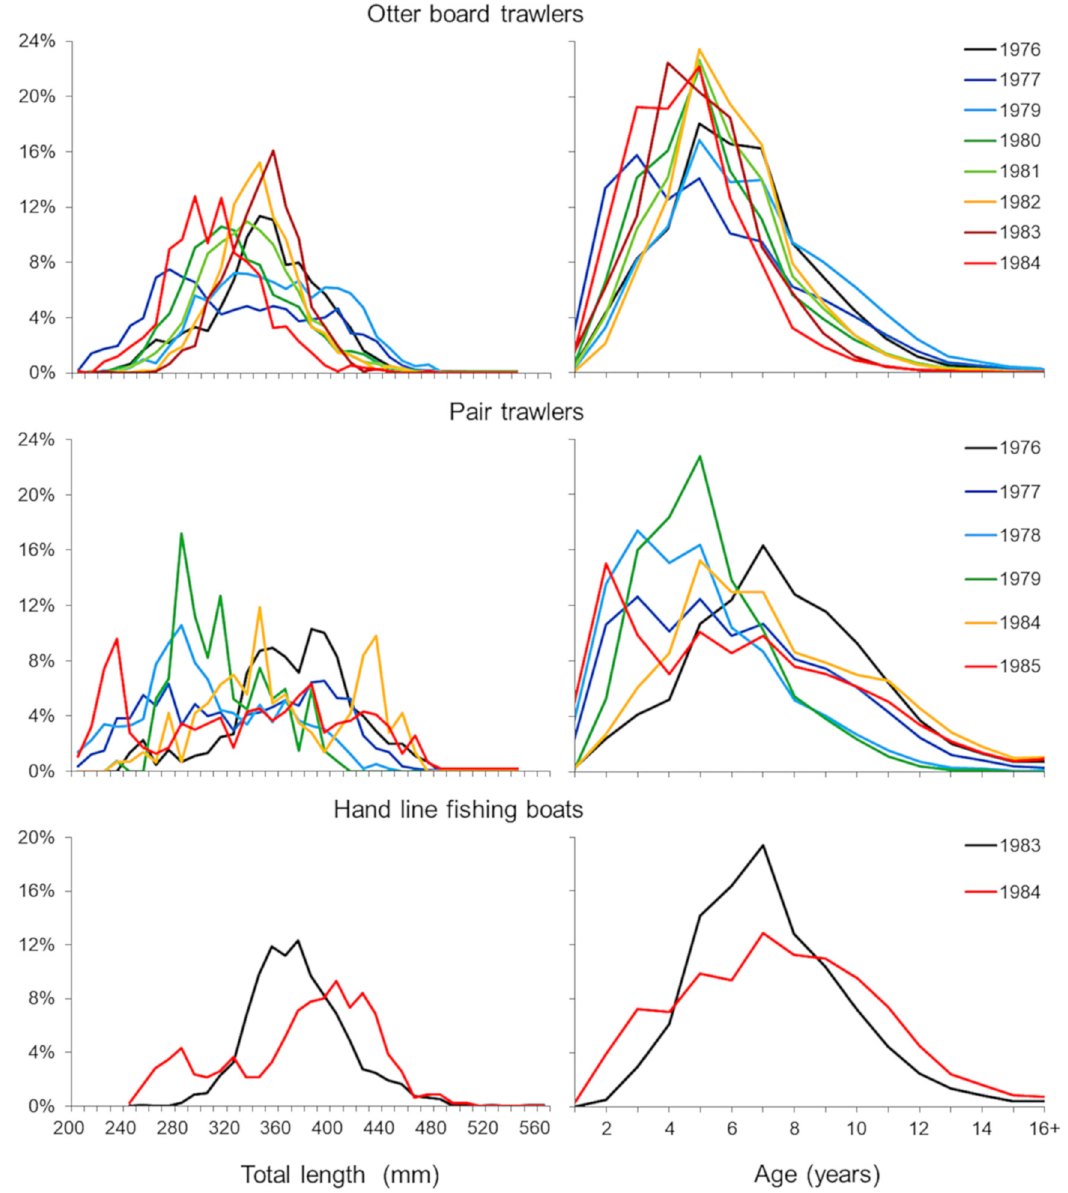
Fig. 12. Relative length and age composition in the landings of Pagrus pagrus fi shed along southern Brazil between 1976 and 1985 by pair trawlers, otter board trawlers, and